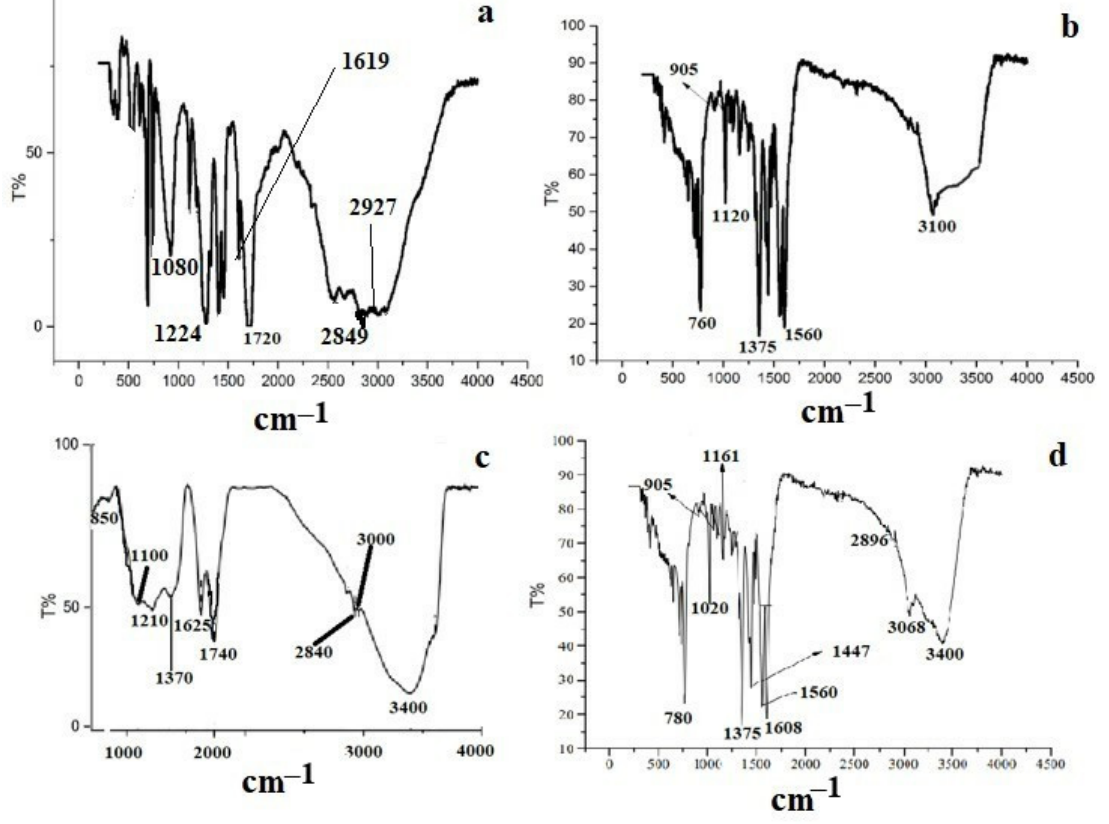
Figure 3. IR spectra of GO ( a ), copper trimesinate ( b ), trimesic acid ( c ) and nanocomposite ( d ).